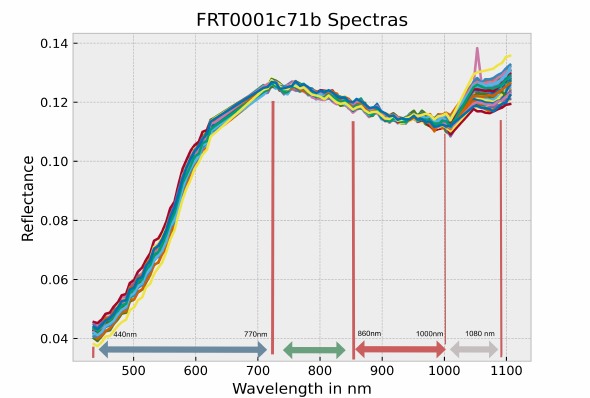
Figure 7. Spectral information with supporting bands, dividing area into four distinct